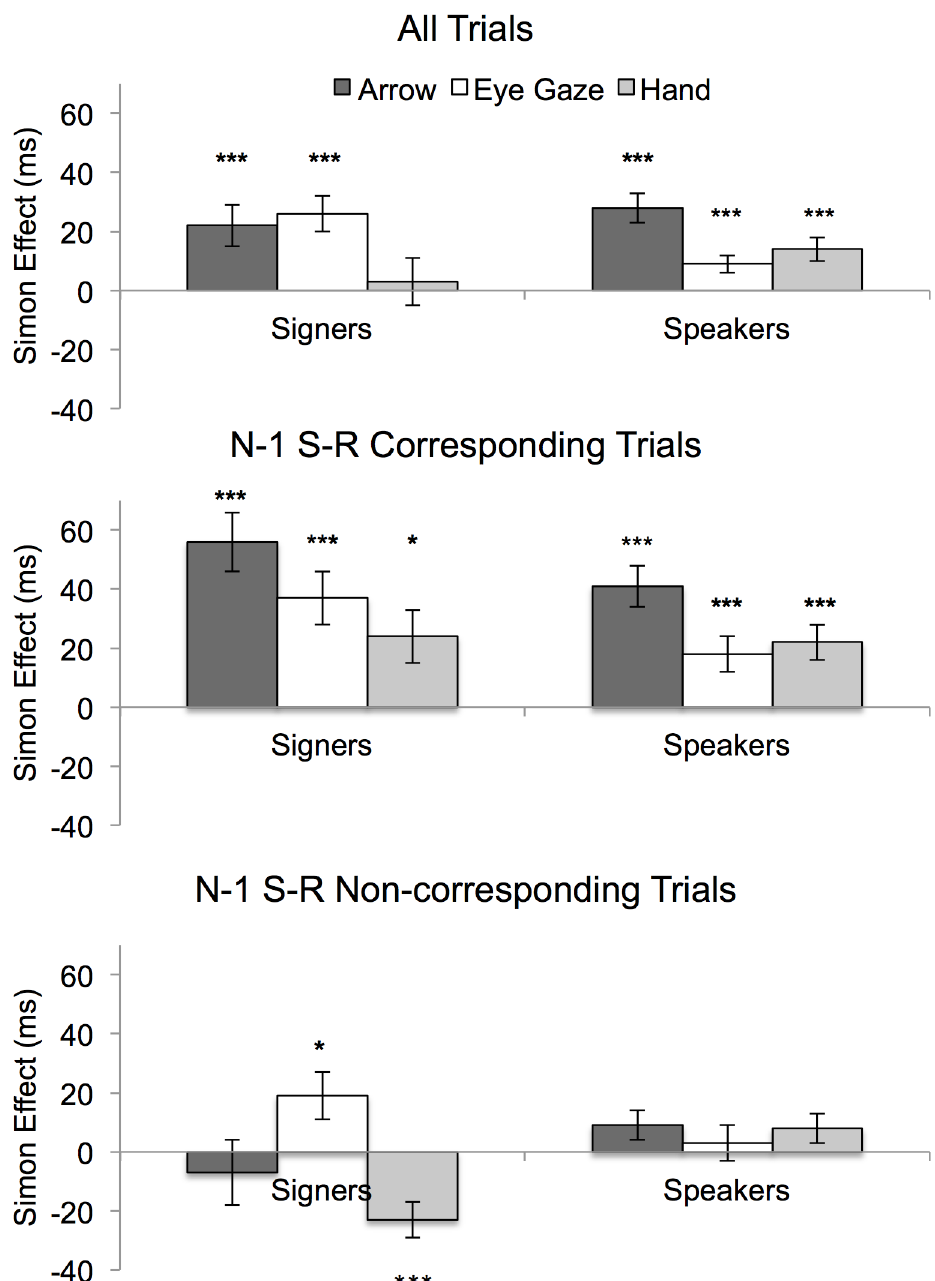
Fig 2. Simon effects (faster RTs to spatially corresponding S-R pairs) found across groups (signers and speakers) and distractors (arrow, eyes, hand). Analyses were based on all trials (top), or only trials immediately preceded by corresponding S-R pairs (middle) or non-corresponding S-R pairs (bottom). The lack of the Simon effect demonstrated by signers in the hand condition (top panel) reflected the opposing effects of spatial congruency induced by N-1 trials. (cid:3) p < .05, (cid:3)(cid:3)(cid:3) p <